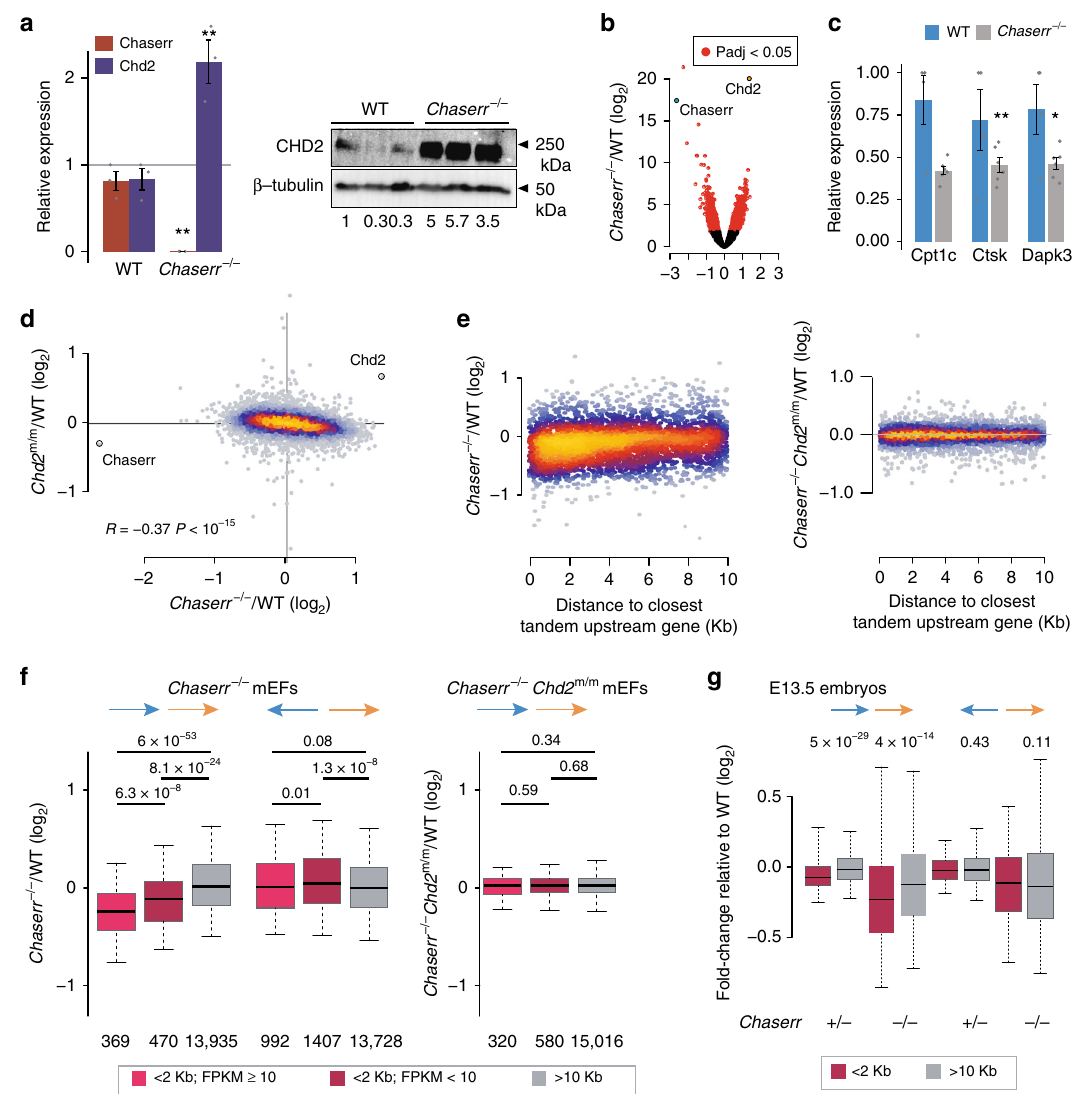
Fig. 4 Transcriptional dysregulation following loss of Chaserr . a qRT-PCR (left) and Western blot (right) of Chd2 expression in mEFs from the indicated background. n = 3. qRT-PCR normalized to Actb . Western blot shows mEFs from three embryos for each background. Error bars show S.E.M. ** P < 0.01 (two-sided t test). b Volcano plots for the indicated differential expression comparison by using DESeq2 62 . c qRT-PCR of the indicated genes in WT and Chaserr − / − mEFs. Normalized to Actb . WT n = 4, Chaserr − / − n = 6 * P < 0.05, ** P < 0.01 (two-sided t test). d Changes in gene expression in Chaserr − / − and Chd2 m/m mEFs. Correlation computed by using Spearman ’ s correlation. Color indicates point density. e Change in expression in Chaserr − / − or Chaserr − / − Chd2 m/m vs. WT mEFs and distance to the 3 ′ end of the closest upstream gene transcribed from the same strand, for genes for which this distance is <10 kb. Color indicates point density. f Changes in gene expression in Chaserr − / − or Chaserr − / − Chd2 m/m vs. WT mEFs for genes with the indicated distances from the closest upstream gene. Genes with distance <2 kb were further subdivided based on the expression levels of the upstream gene. The number of genes in each group is indicated below the distance threshold. Boxplots show the 5th, 25th, 50th, 75th, and 95th percentiles. g As in f , for the E13.5 whole embryo RNA-seq. P -values computed by using Wilcoxon rank-sum test. Ratio quanti fi cations are shown below Western blots. Source data are provided as a Source Data fi le. Boxplots show the 5th, 25th, 50th, 75th, and 95th